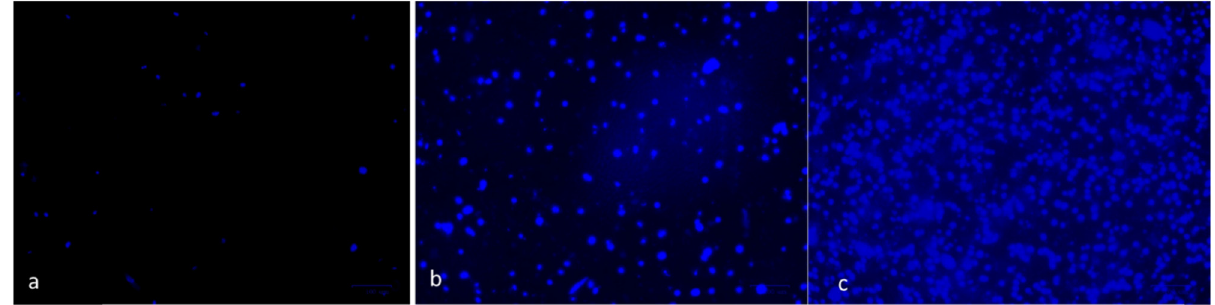
Figure 9: DAPI nuclear staining was used to determine apoptosis in MOLT4 cells after 24 h of treatment with IC 50 doses of ZnO – TiO 2 – chitosan – escin bio - nanocomposites. ( a ) Untreated control cells, ( b ) cells treated with 30 μ g · mL − 1 , and ( c ) 40 μ g · mL − 1 of ZnO – TiO 2 – chitosan – escin bio - nanocomposite ) . These are representative images of the experiment performed in triplicates with magni fi - cation at 20 ×